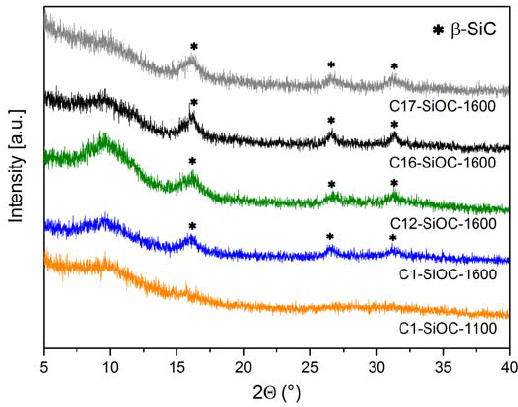
Figure 1. XRD patterns ( λ = Mo K α ) of the investigated silicon oxide carbides (SiOC) materials [24].